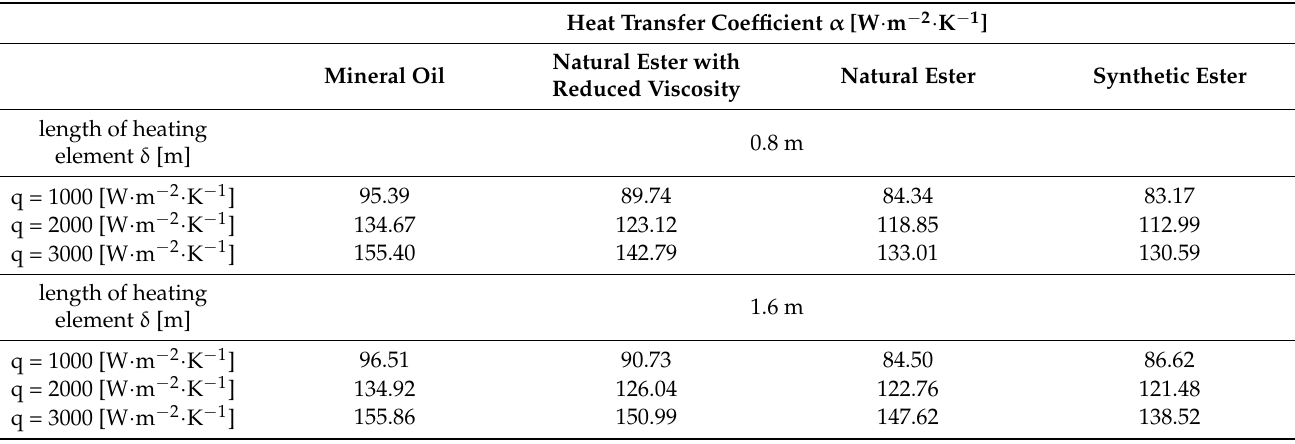
Table 3. The results of measurements of heat transfer coefficient α depending on the type of electrical insulation liquid, the heat load of the cooled surface q, and the length of the heating element δ .